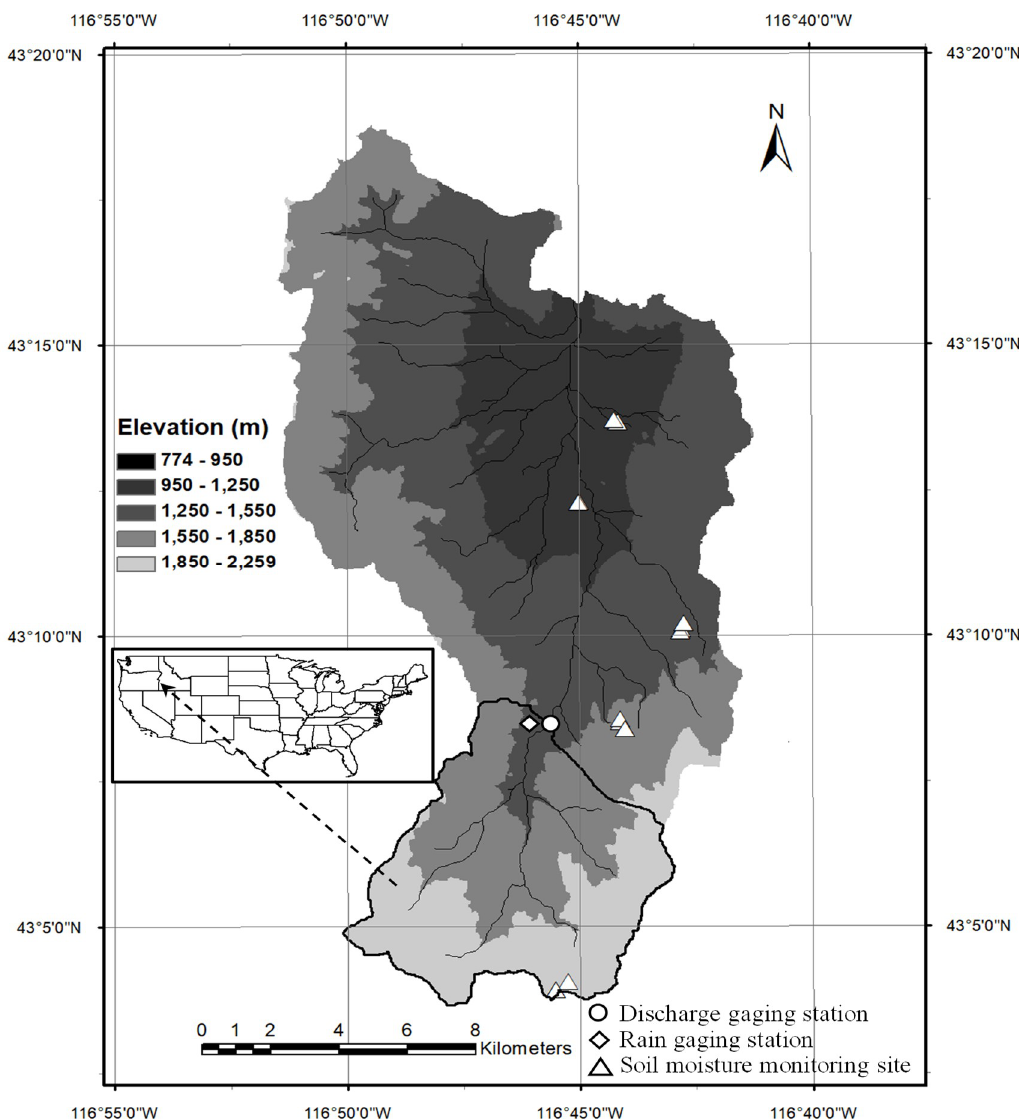
Figure 1. Location of the study watershed in the Reynolds Creek Experimental Watershed in southwest Idaho, USA.